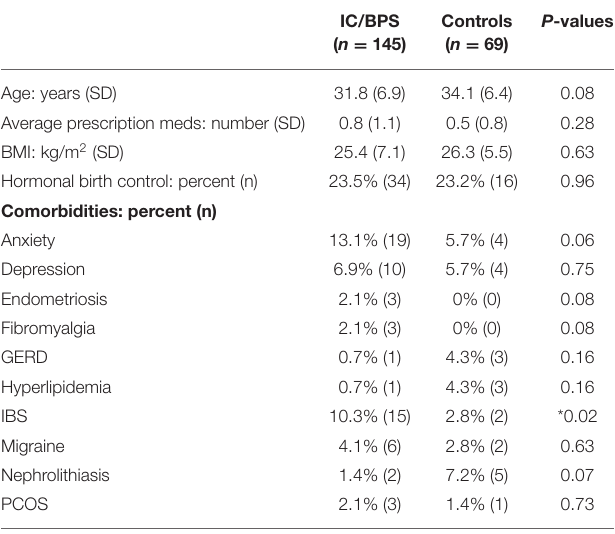
TABLE 1 | Patient